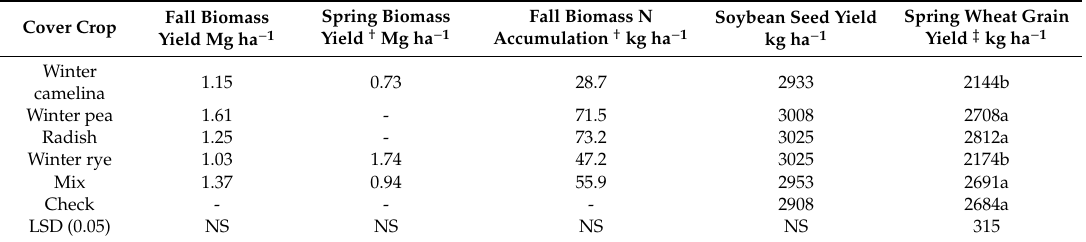
Table 5. Mean fall and spring cover crop biomass yield, N accumulation, soybean, and spring wheat grain yield for five cover crops and a no cover crop check averaged across two cover crop sowing dates and four environments at Fargo and Prosper, ND, in 2016 to